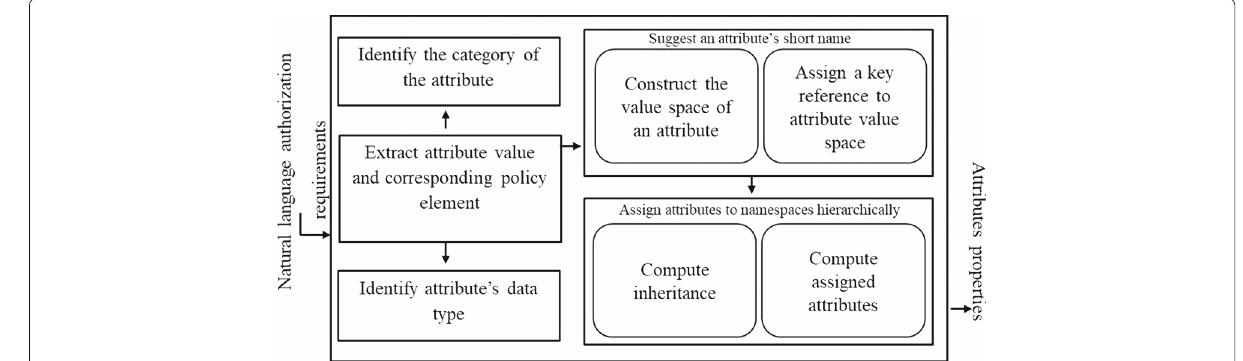
Fig. 4 High level overview of the proposed attributes extraction